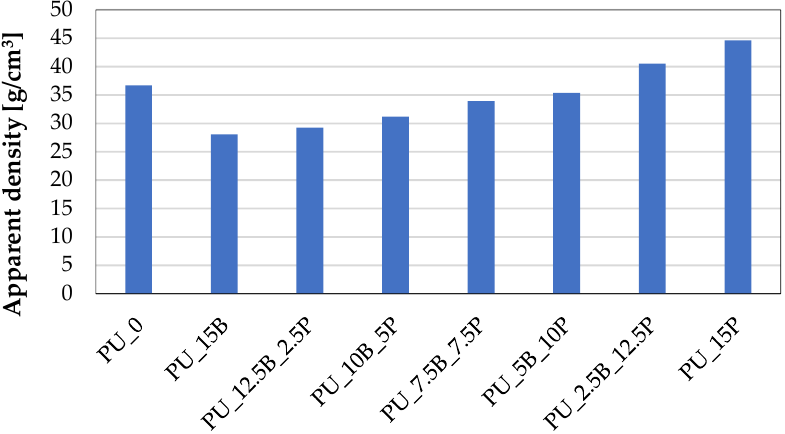
Figure 4. Apparent density of rigid PU foams containing buckwheat hulls and perlite in different amounts.